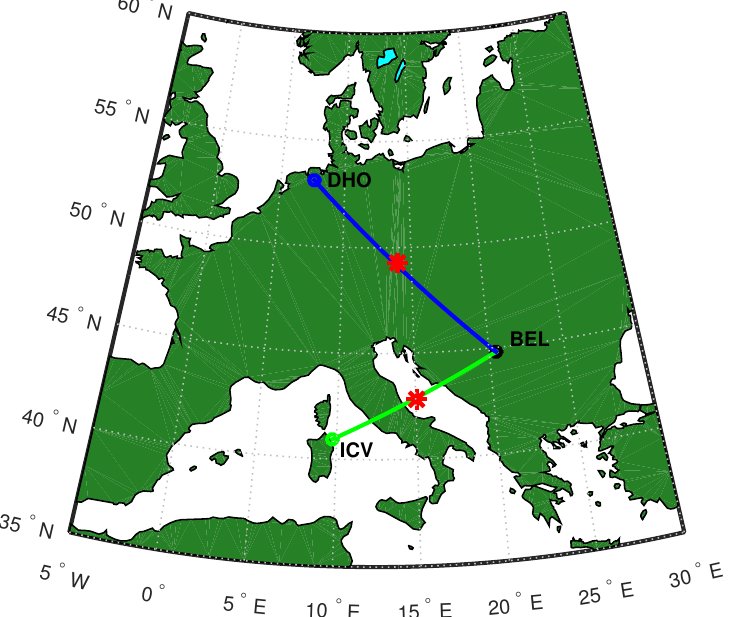
Figure 5. Propagation paths of the main and auxiliary VLF signals emitted by the DHO (Germany) and ICV (Italy) transmitters, respectively, and received in Belgrade (BEL). The stars indicate the locations of the path